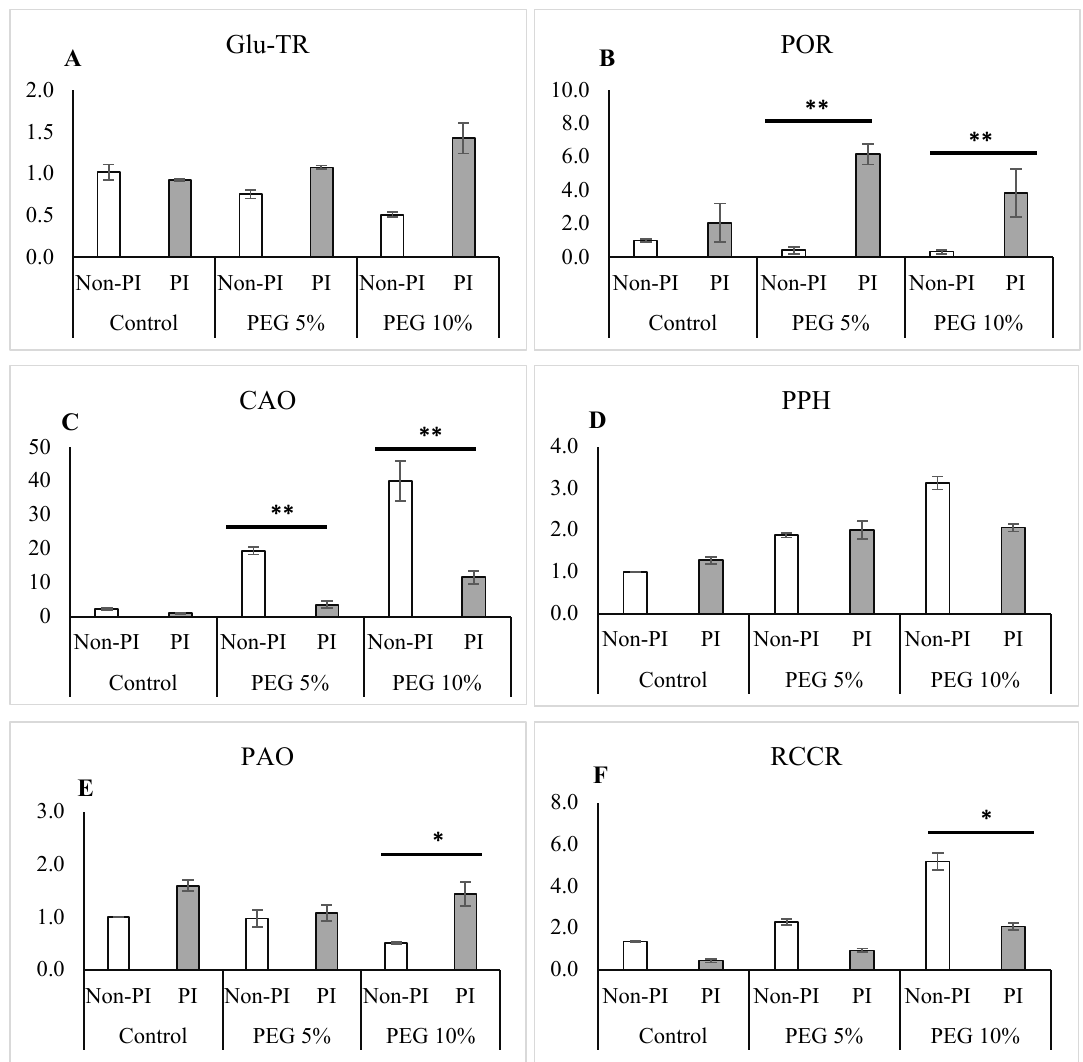
Figure 7. qPCR expression profile of chlorophyll biosynthesis and degradation genes in the third leaf of cucumber grown under 2 PEG levels (5 and 10%) 15 days post P. indica co-cultivation. ( A ) Glu-TR, glutamyl-tRNA reductase ( B ) POR, protochlorophyllide oxidoreductase ( C ) CAO, chlorophyll a oxygenase ( D ) PPH, pheophytinase ( E ) PAO, pheophorbide a oxygenase, ( F ) RCCR, red chlorophyll catabolite reductase for colonized and non-colonized P. indica (PI) plants. Actin gene was used for normalization. Data are mean fold changes of three independent experiments each containing three repeats. Asterisks indicate significance at ** p < 0.01 and * p < 0.05 by student t -test.